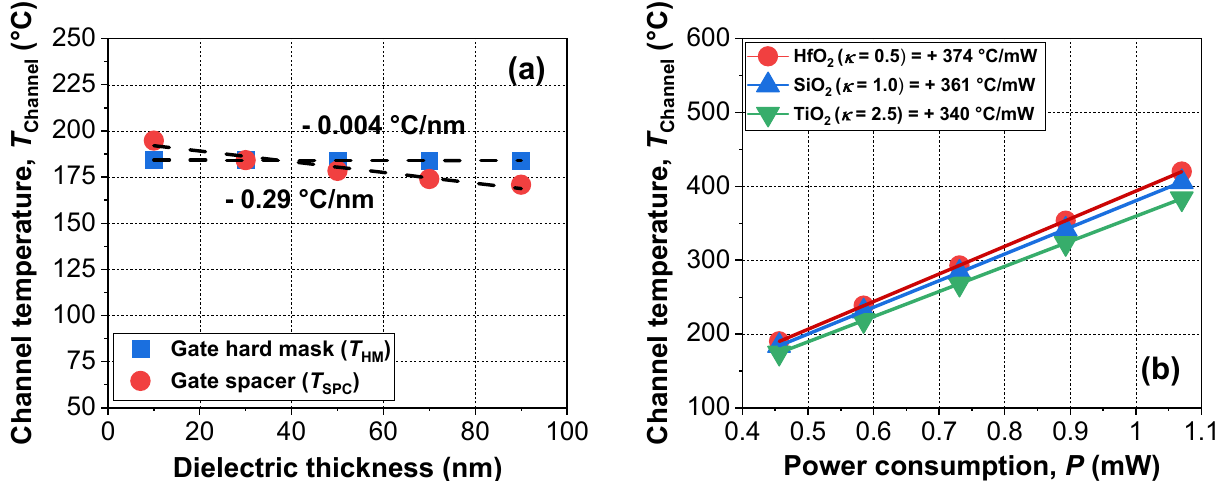
Figure 7. Extracted T Channel of devices with various ( a ) dielectric thicknesses and ( b ) materials of gate hard mask and gate spacer. Dashed lines indicate fitting of the symbols.